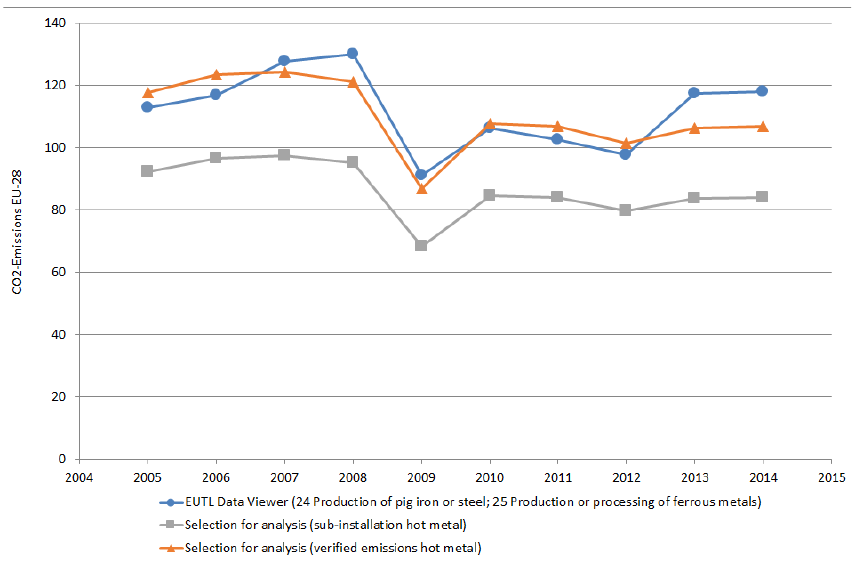
Figure 7. Overall greenhouse gas emissions (Mt CO 2 -equ.) of iron making from two different sources. Source: Selection for analysis from EUTL (verified emissions) and own calculations for the sub-installation molten metal [19], EUTL Data Viewer [25].